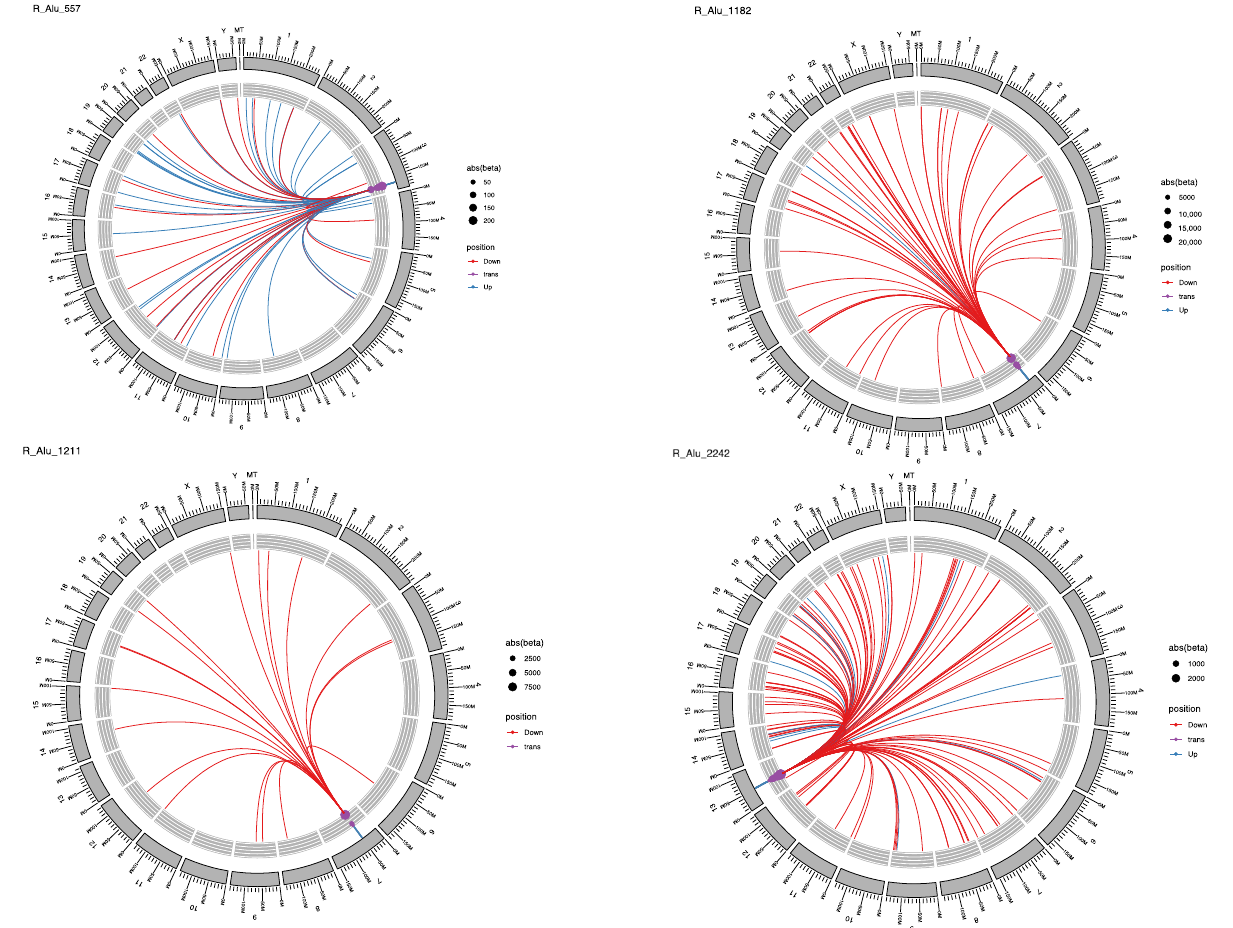
Figure 6. Circos plots showing the targets and effects for four different Alus . Blue line is for up-regulation; red line is for down-regulation of the gene. Dot size is beta value; dot colour is trans or cis effect.